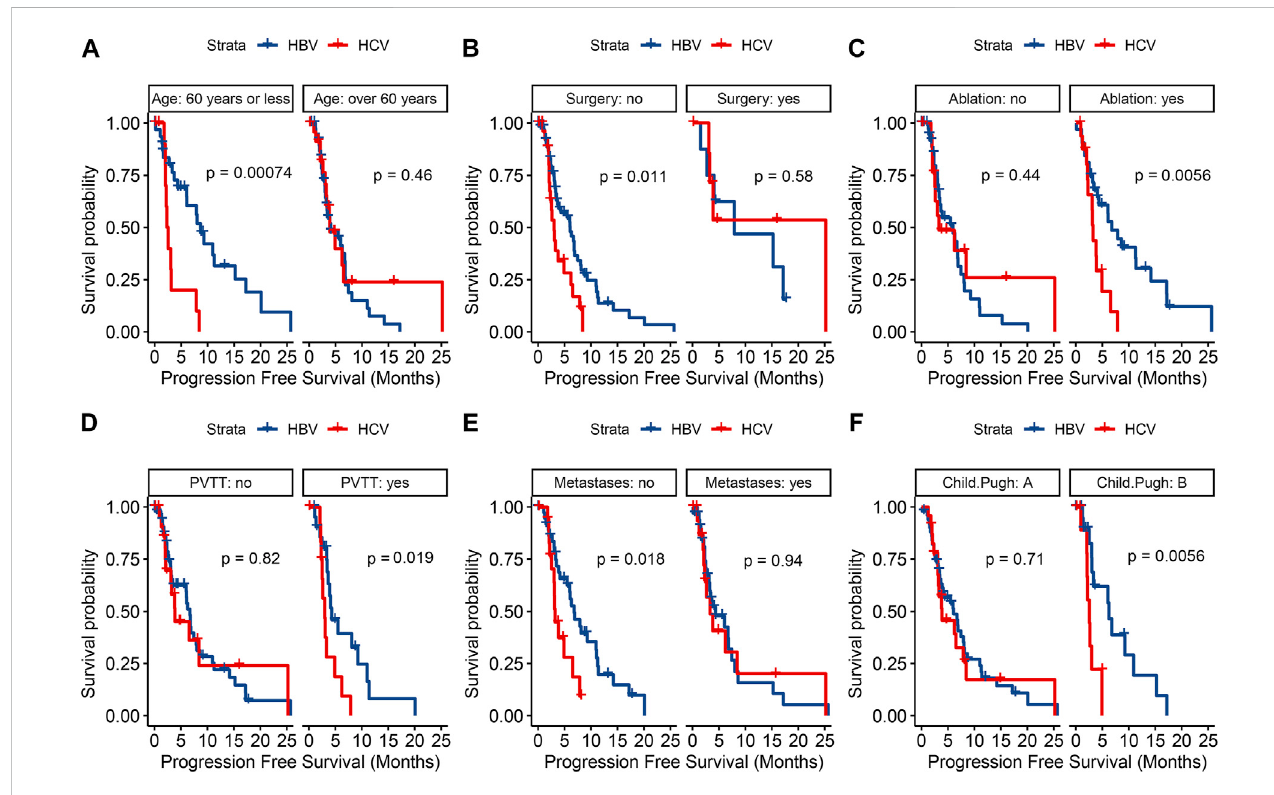
FIGURE 5 Kaplan-Meier curves for progression-free survival in terms of age (A) surgical history (B) ablation history (C) portal vein tumor thrombus (D) extrahepatic metastasis (E) and Child-Pugh grade (F) between the two